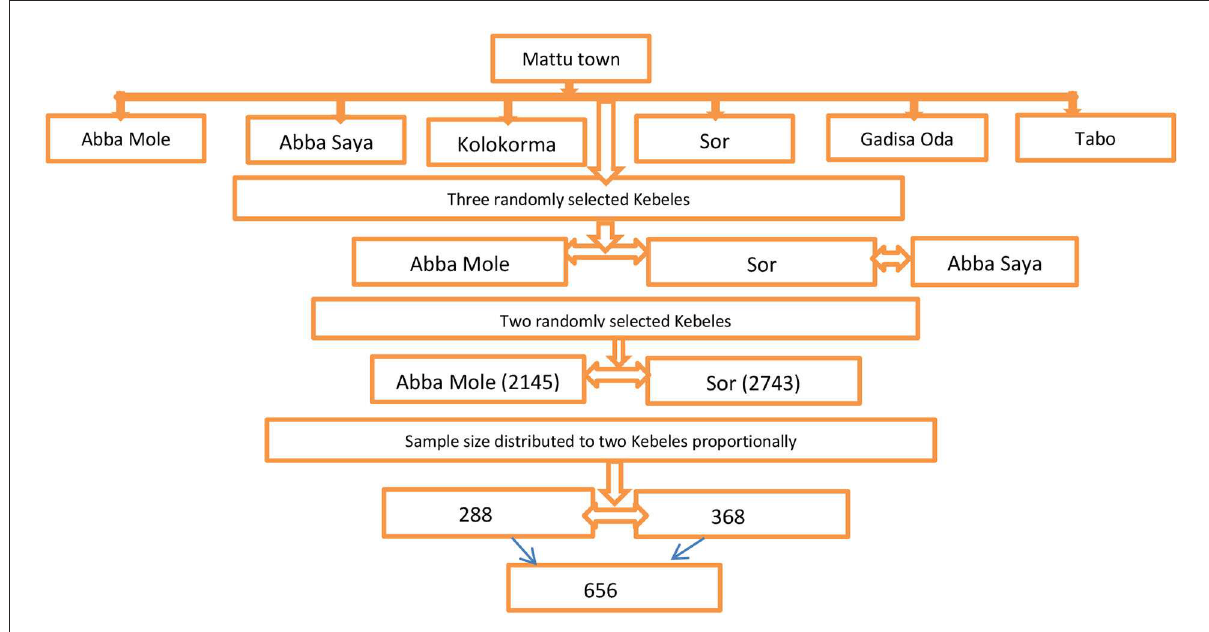
FIGURE1 Schematic representation of sampling procedure of Mattu town Kebeles, Oromia Regional State, Ethiopia,